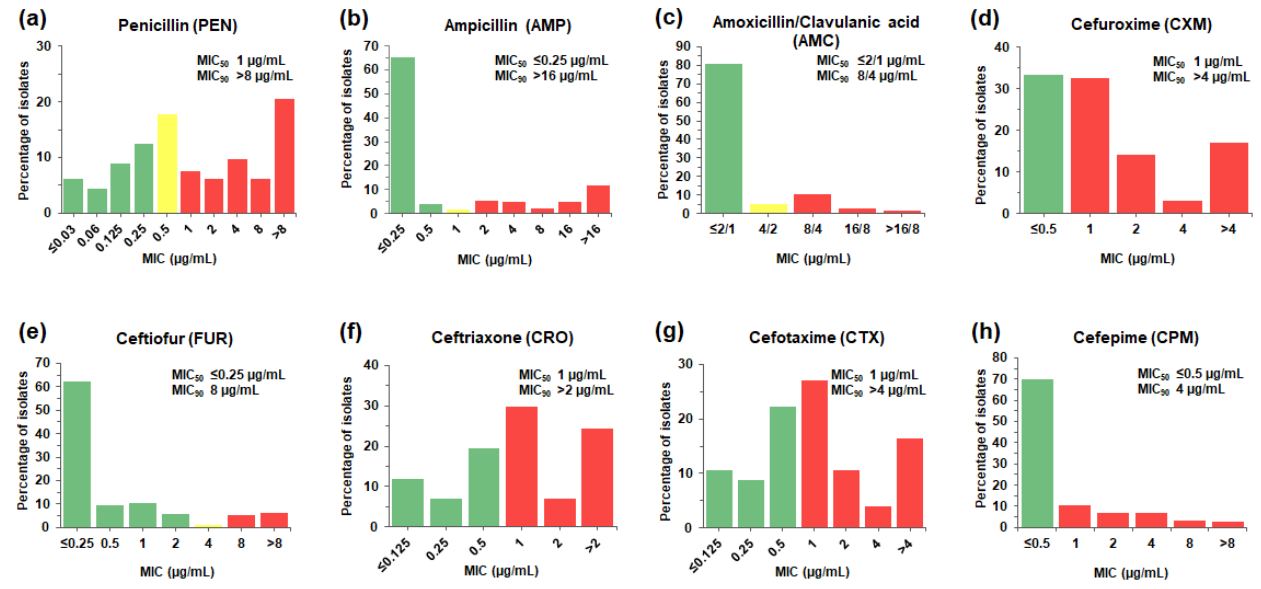
Figure 1. MIC distributions of β -lactam antibiotics for the 225 S. suis isolates. The frequencies of different MICs for each of the β -lactams tested were tabulated as a percentage of isolates (%) with a particular MIC value ( µ g/mL) for penicillin ( a ), ampicillin ( b ), amoxicillin/clavulanic acid ( c ), cefuroxime ( d ), ceftiofur ( e ), ceftriaxone ( f ), cefotaxime ( g ), and cefepime ( h ). The color of bar charts indicates interpretive range for each of the antibiotics; susceptible (green), intermediate (yellow), and resistant (red). MIC 50 and MIC 90 , the MIC which inhibit 50% and 90% of the isolates tested, respectively, were also indicated.